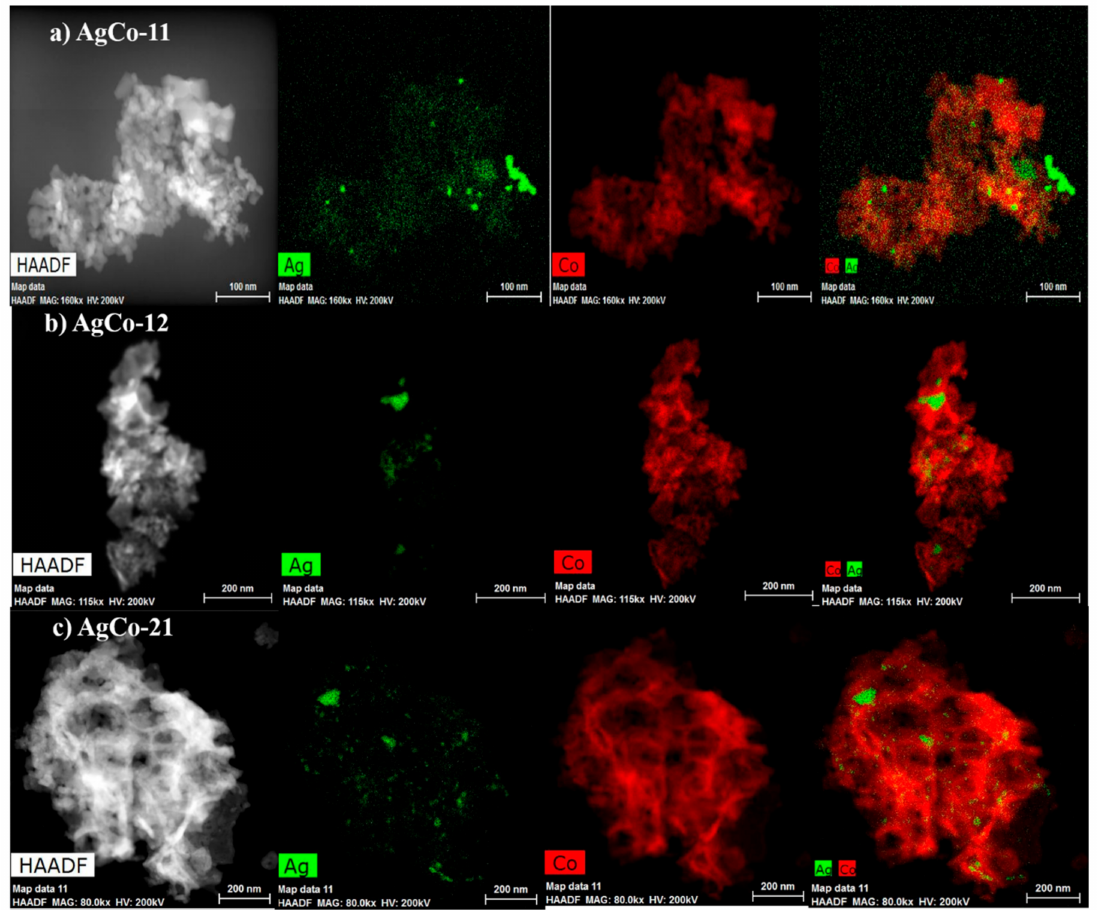
Figure 6. Elemental phase mapping by high-angle annular dark-field scanning transmission electron microscopy (HAADF-STEM) image for the synthesized ( a ) AgCo-11, ( b ) AgCo-12 and ( c ) AgCo-21